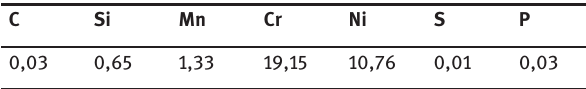
Table 1: Chemical composition (% of mass) of the SAE 304L test plate.